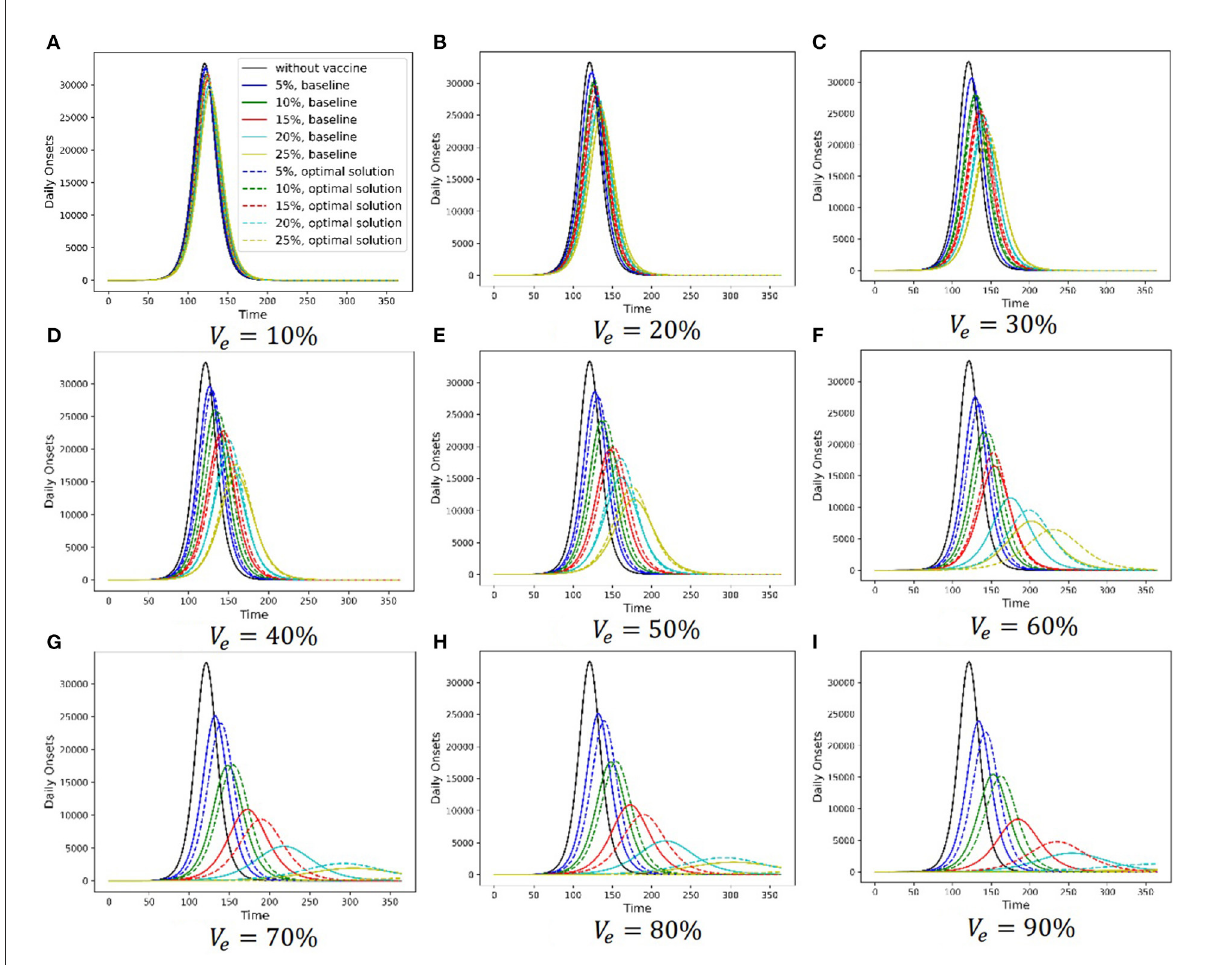
FIGURE6 Simulation comparation between the chosen optimal strategy and